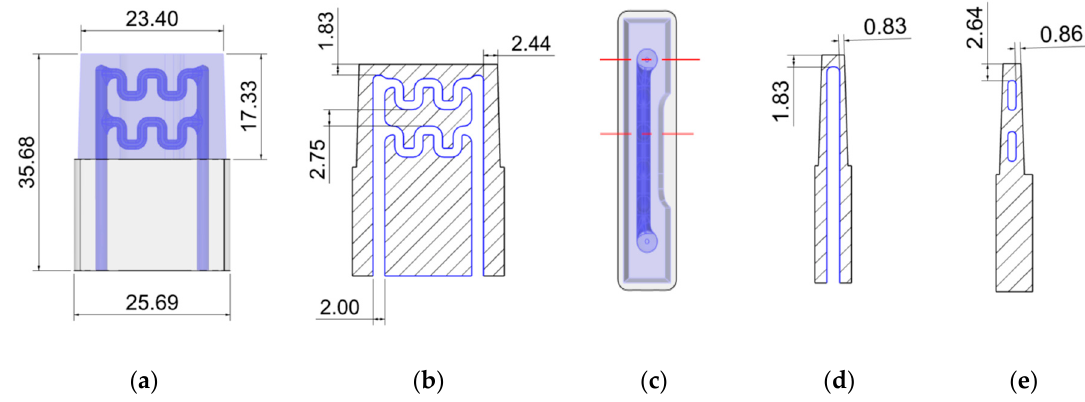
Figure 5. Cooling insert redesigns, incorporating cooling channels. ( a ) Exterior sizes of the cooling insert redesigns (front view). ( b ) Cooling channel dimensions of the cooling insert redesigns (front view). ( c ) Cooling insert redesigns with indication of sections ( d ) and ( e ) (top view). ( d ) Cooling channels side minimum distances to the exterior of the insert (side view). ( e ) Cooling channels central minimum distances to the exterior of the insert (side view). Dimensions in mm.